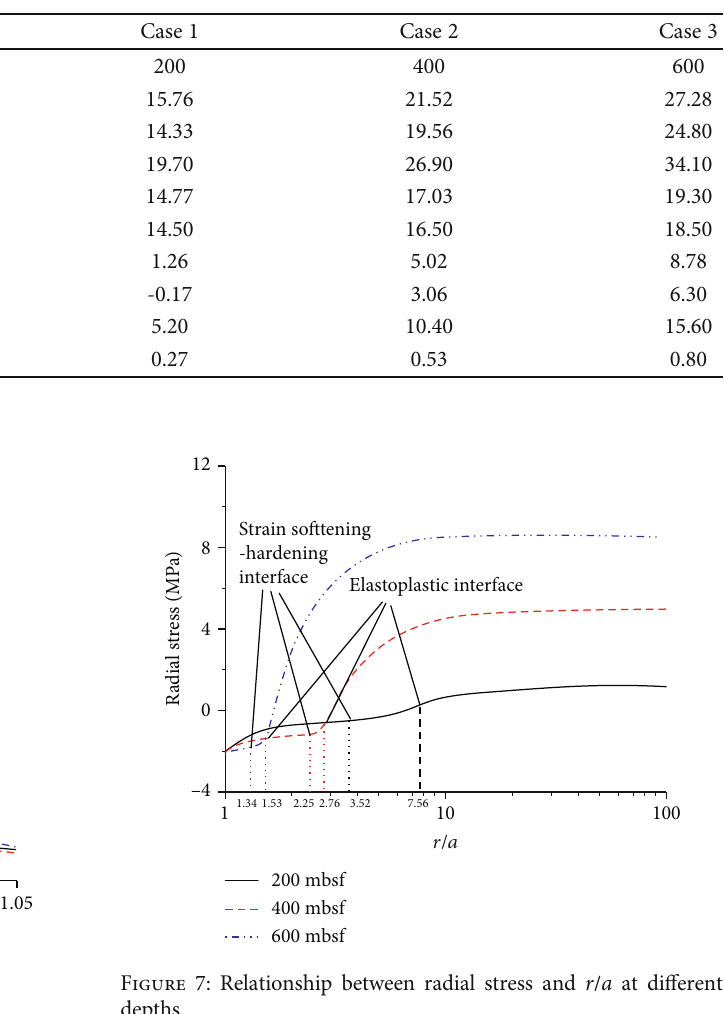
Table 2: Parameter values used in the analysis of in fl uencing factors.